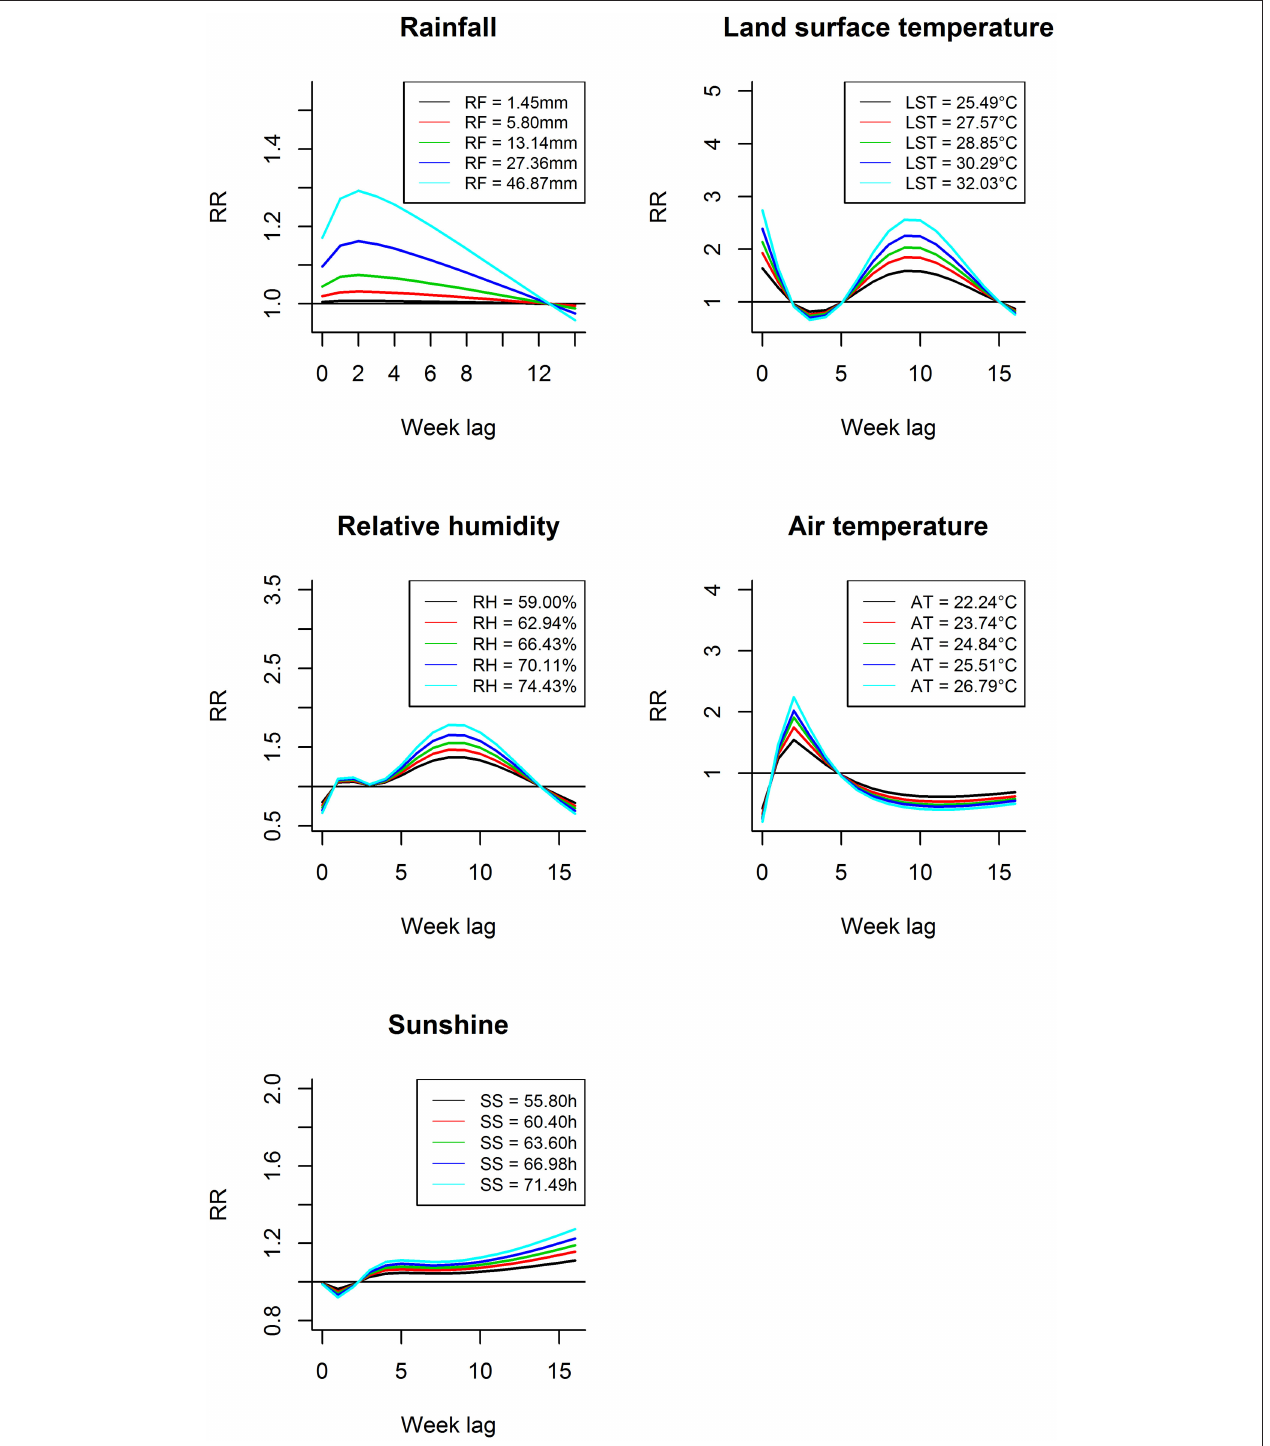
FIGURE 3 | Lag-response curves for different weather variables in their diverse exposure levels (50, 60, 70, 80, and 90%).